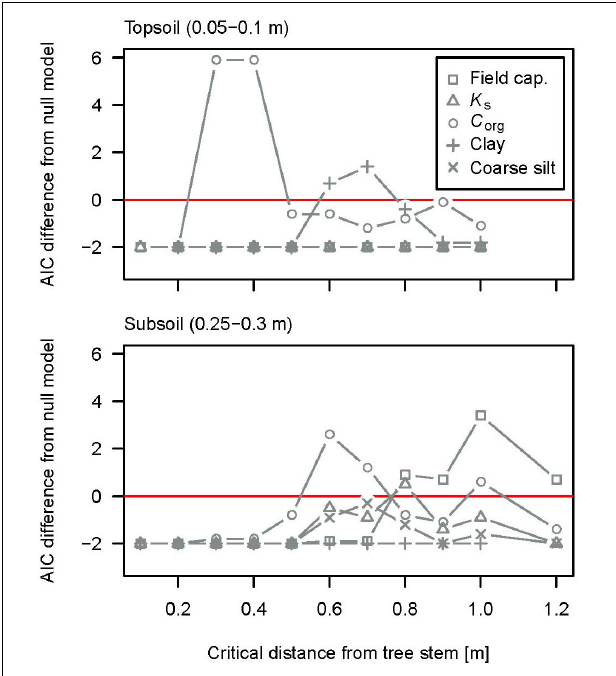
FIGURE 7 | Results for linear mixed-effects models separating the sample in microsites near and forest sites far from stem, for different microsite sizes. Values on the x -axis give the microsite extent in terms of distance from the stem. The y -axis gives the difference between the Akaike information criterion (AIC) of the Null model (no distance classification included) and the microsite model. Positive values on the x -axis imply model improvement when microsites are accounted for. The highest positive value on the y -axis was taken to indicate the best fit model for the size of the tree microsite for each soil property. Field cap.: soil water content at field capacity (vol-%); K s : saturated soil hydraulic conductivity (mm h − 1 ) (log-transformed); C org : soil organic carbon content (%); Clay: clay content (%); Coarse silt: coarse silt content